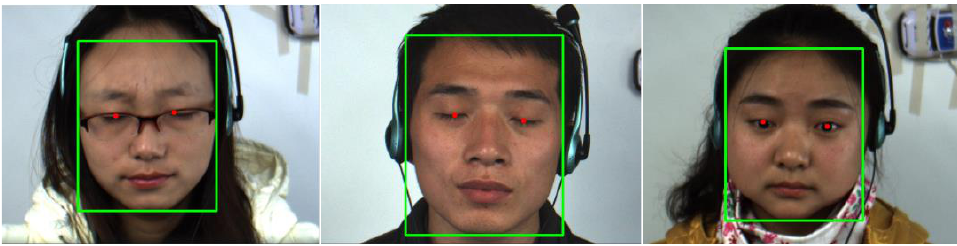
Figure 2. Face and eye detection using MTCNN. Green box: detected face boundary. Red dots: detected eyes’ center points.